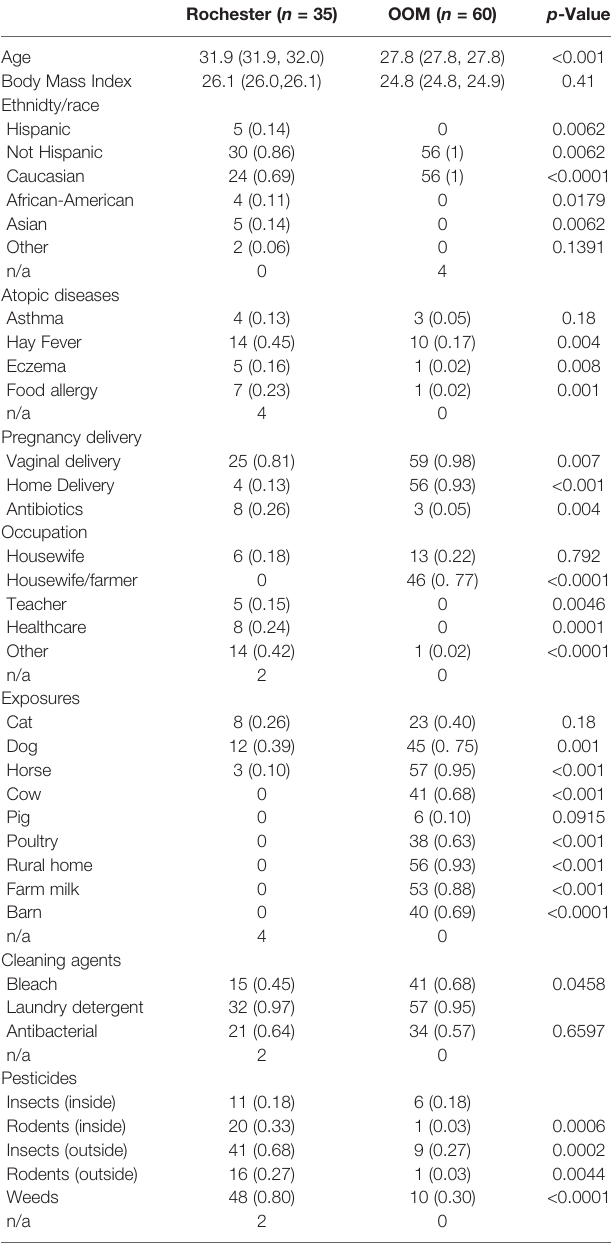
TABLE 1 | Demographics and exposures of the study